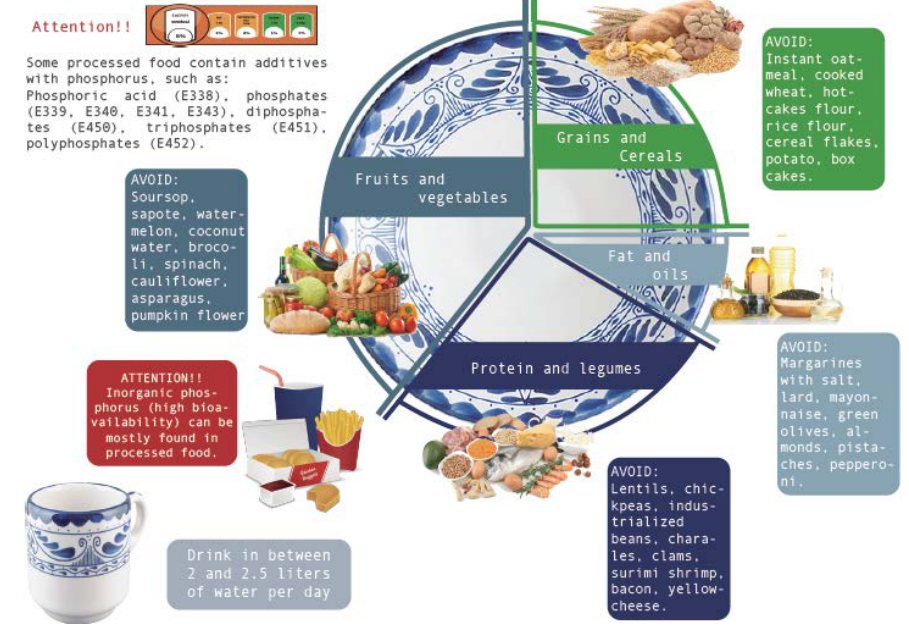
Figure 1. The Low Phosphate Plate.